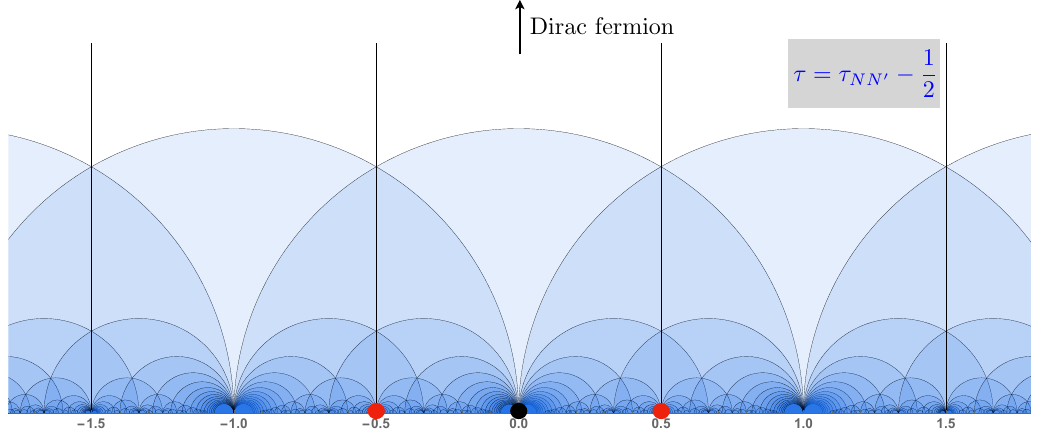
Figure 4 . The upper-half plane of the gauge coupling (cid:28) (cid:28) DN we (cid:12)nd the O (2) model on the boundary. Thanks to particle-vortex duality, the cusp ! 1 in the origin (cid:28) DN = 0 also gives a decoupled O (2) model on the boundary. Thanks to the boson- fermion duality between U(1) 1 coupled to a critical scalar and a free Dirac fermion, the cusps at (cid:28) DN = 1 give a free Dirac fermion. (cid:6)